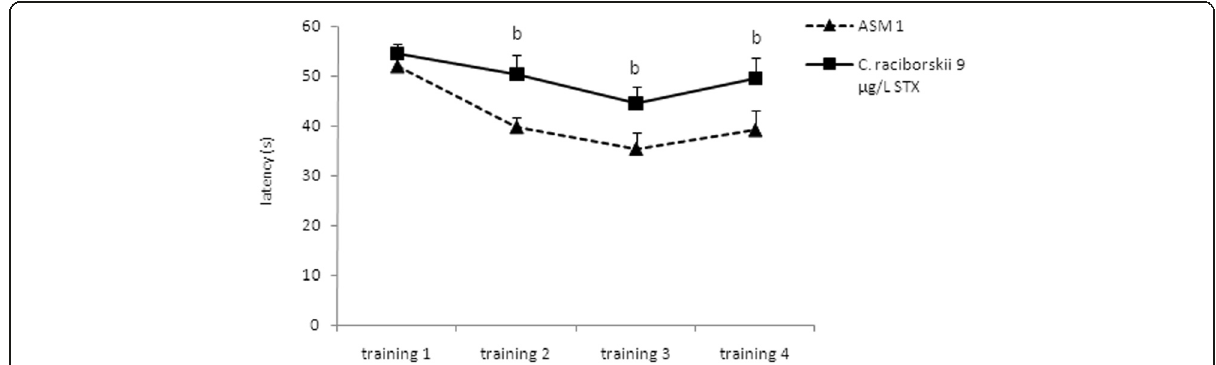
Fig. 5 Effect of consumption of cyanobacteria-contaminated drinking water in the training trial of MWM task. Data expressed as mean ± SEM; n = 15 rats per group. Both groups showed significant reduction in latency to find the platform during the four training days ( p <0.05, repeated measure ANOVA). The PST-producing C. raciborskii (9 μ g/L STX equivalents) group showed a significant difference compared to the control group ( p <0.05, repeated measure